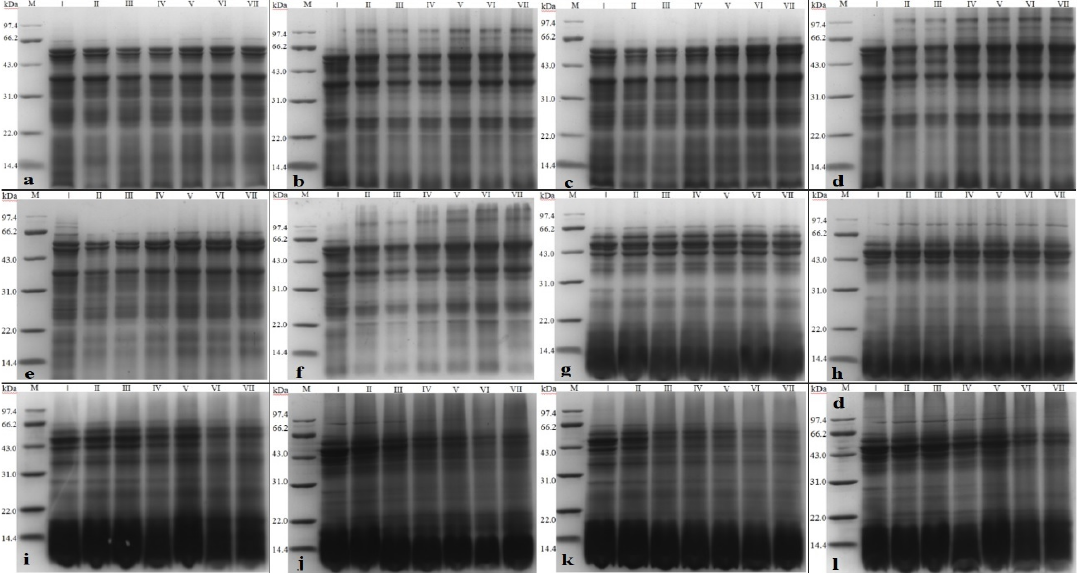
Figure 7. Electrophoresis analysis of extruded rice bran protein. Note: ( a , b ) in the figure represent the protein non-reducing and reducing electrophoresis of untreated rice bran stored at 15 ◦ C, respectively; ( c , d ) represent the non-reducing and reductive electrophoresis of untreated rice bran stored at 25 ◦ C, respectively. ( e , f ) non-reducing protein and reducing electrophoresis of untreated rice bran stored at 40 ◦ C; ( g , h ), respectively, are the non-reducing and reductive electrophoresis of extruded rice bran stored at 15 ◦ C.; ( i , j ) represent the protein non-reducing and reduction electrophoresis of the extruded rice bran stored at 25 ◦ C, respectively; ( k , l ) represent the non-reduced protein of the extruded rice bran stored at 40 ◦ C, respectively. Prototype electrophoresis and reduction electrophoresis analysis; lanes I–VII are protein non-reduced and reduced electrophoresis analysis of rice bran stored at 0, 10, 20, 30, 40, 50, and 60 d,